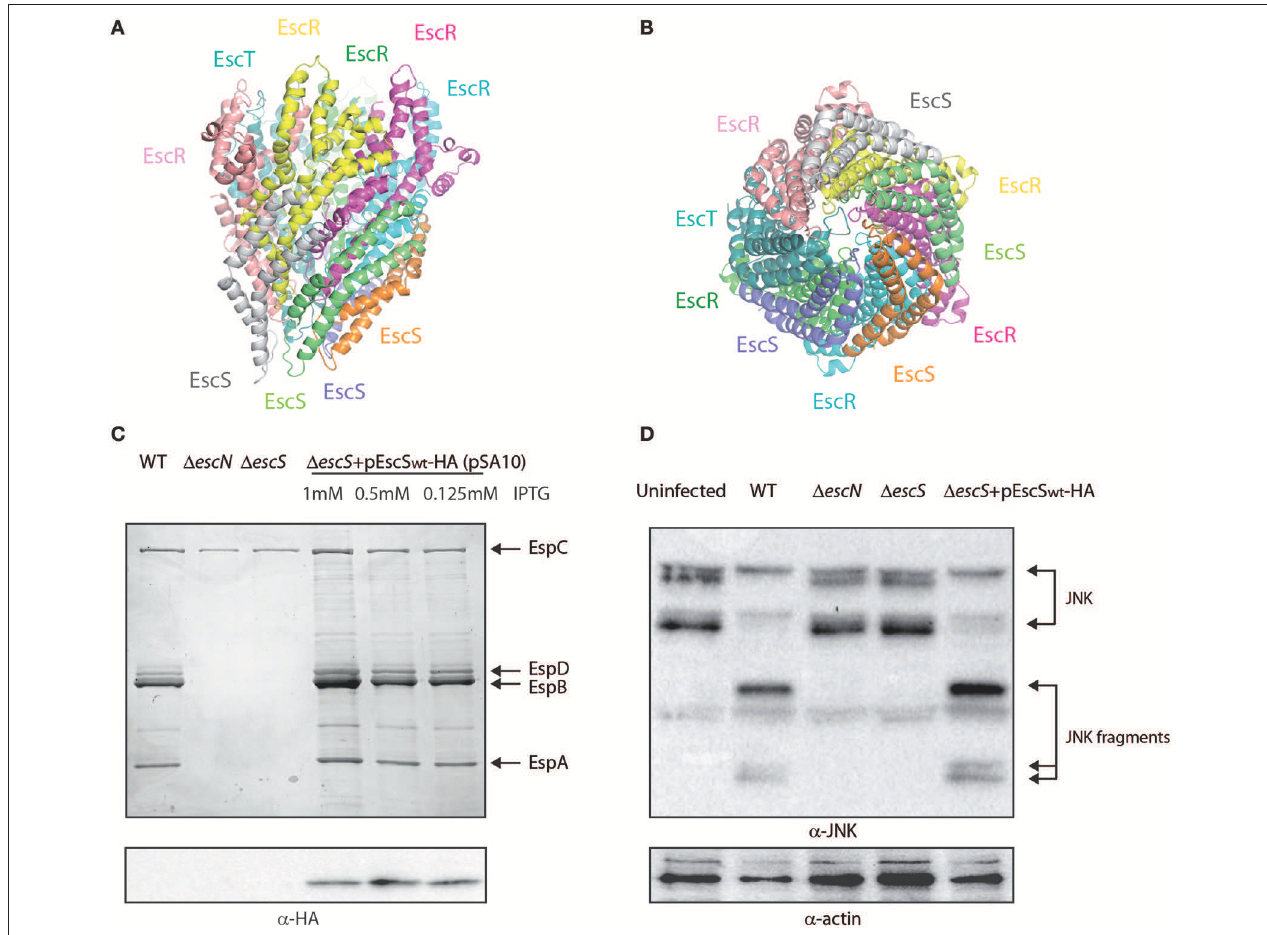
FIGURE 1 | EscS can complement 1 escS . (A) Side-view of the EscR 5 S 4 T complex based on the PDB 6F2D complex of the flagellar FliP 5 Q 4 R complex of Salmonella . Protein subunits are labeled with their corresponding color in the model. (B) Bottom-view of the EscR 5 S 4 T complex. (C) Protein secretion profiles of EPEC strains grown under T3SS-inducing conditions: wild-type (WT) EPEC, 1 escN (a T3SS ATPase mutant), 1 escS , and 1 escS carrying the pEscS wt -HA and treated with different IPTG concentrations. The secreted fractions were concentrated from the supernatants of bacterial cultures and analyzed by SDS-PAGE and Coomassie blue staining. The T3SS-secreted translocators EspA, EspB, and EspD are marked on the right of the gel. Also indicated is the location of EspC, which is not secreted via the T3SS. For the 1 escN and 1 escS strains, no T3SS activity was observed. The 1 escS strain carrying the plasmid encoding EscS wt -HA showed proper T3SS activity, regardless of the IPTG concentration used. EscS wt -HA expression was detected when bacterial pellets were analyzed on SDS-PAGE and western blot analysis with an anti-HA antibody. (D) Proteins extracted from HeLa cells infected with WT, 1 escN, 1 escS, and 1 escS carrying the pEscS wt -HA were subjected to western blot analysis using anti-JNK and anti-actin (loading control) antibodies. JNK and its degradation fragments are indicated at the right of the gel. WT EPEC showed massive degradation of JNK relative to the uninfected sample and the samples infected with 1 escN or 1 escS mutant strains. EPEC 1 escS complemented with pEscS wt -HA showed similar JNK degradation profile as observed for WT EPEC, indicating a functional complementation.